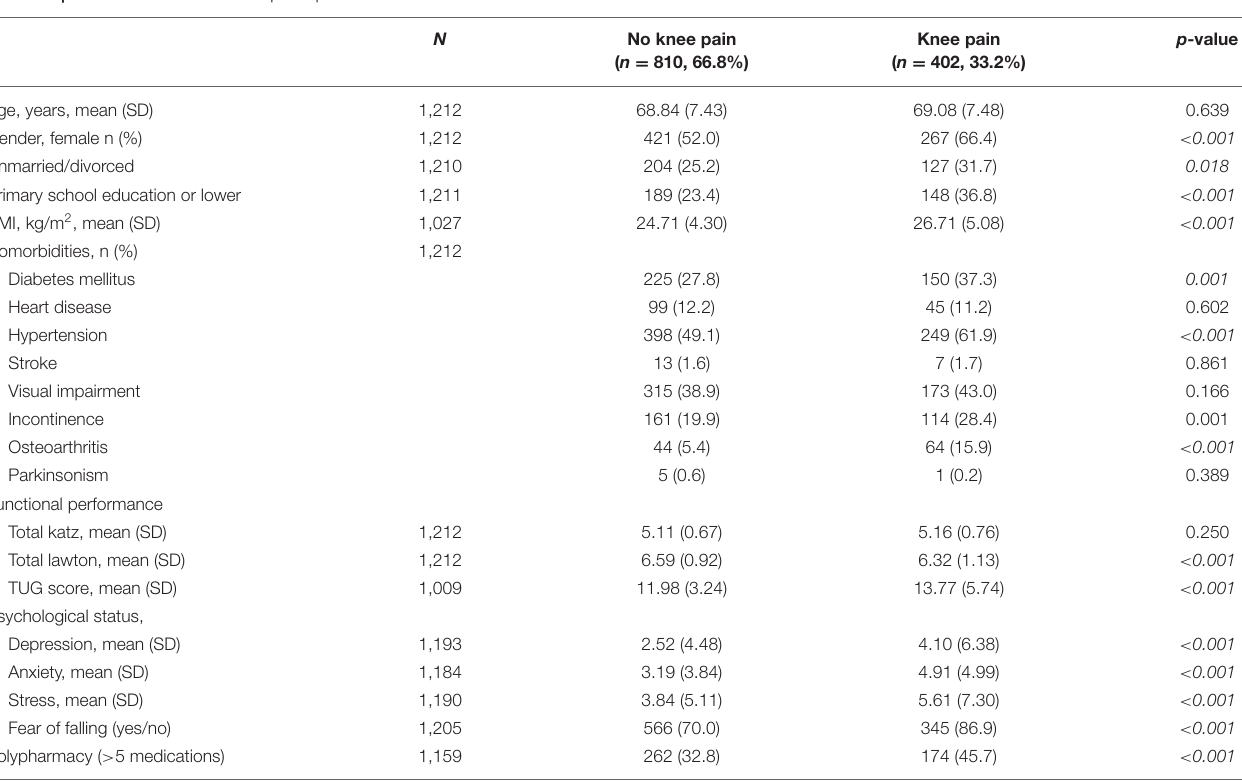
TABLE 1 | Baseline characteristics of